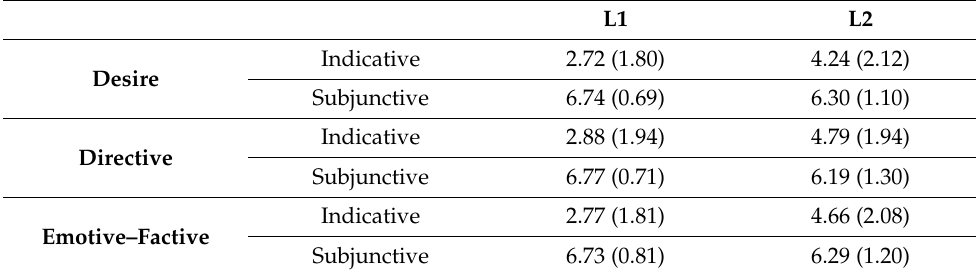
Table 4. Raw means (standard deviations) for judgment ratings (scale